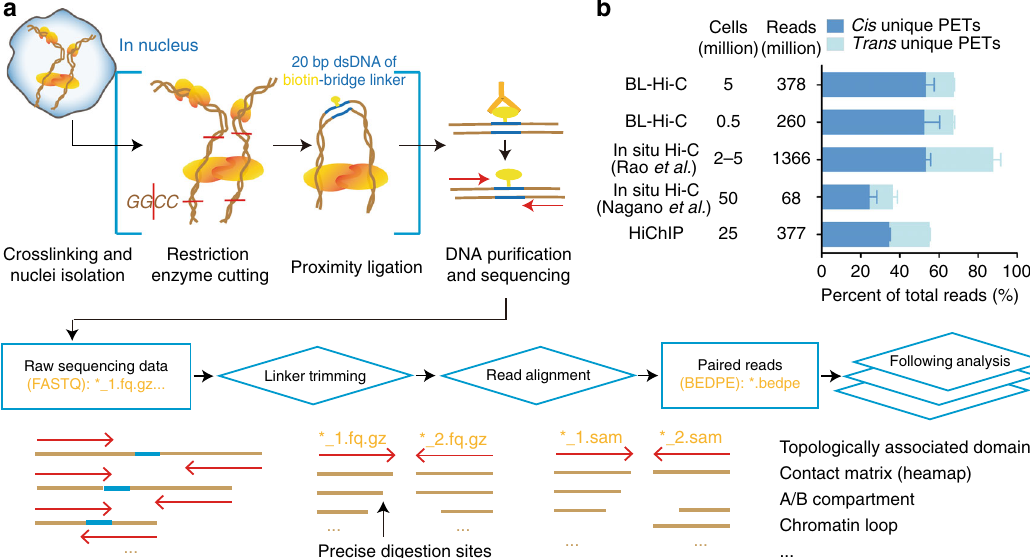
Fig. 1 Overview of BL-Hi-C method. a Work fl ow. Brie fl y, cells are treated with formaldehyde for protein-DNA crosslinking and lysed to access the nuclei. Then, the DNA is digested by the enzyme Hae III (which recognizes “ GGCC ” ) and connected with the bridge linker during proximity ligation. After the DNA fragments are puri fi ed and shared, the biotin-labeled DNA is captured for sequencing. The sequencing data are processed with ChIA-PET2 to perform linker trimming, the alignment of reads to the genome and the formation of uniquely mapped paired-end tags (PETs), which are adapted for downstream analysis. See Methods for the detailed protocol and Supplementary Fig. 1 for the enrichment models. b Ef fi ciency comparison of BL-Hi-C and the published in situ Hi-C and HiChIP methods. The cis- unique PETs refer to the paired reads uniquely mapped on the same chromosome, and trans- unique PETs refer to paired reads mapped on different chromosomes. For each method, the cells and sequencing depth are